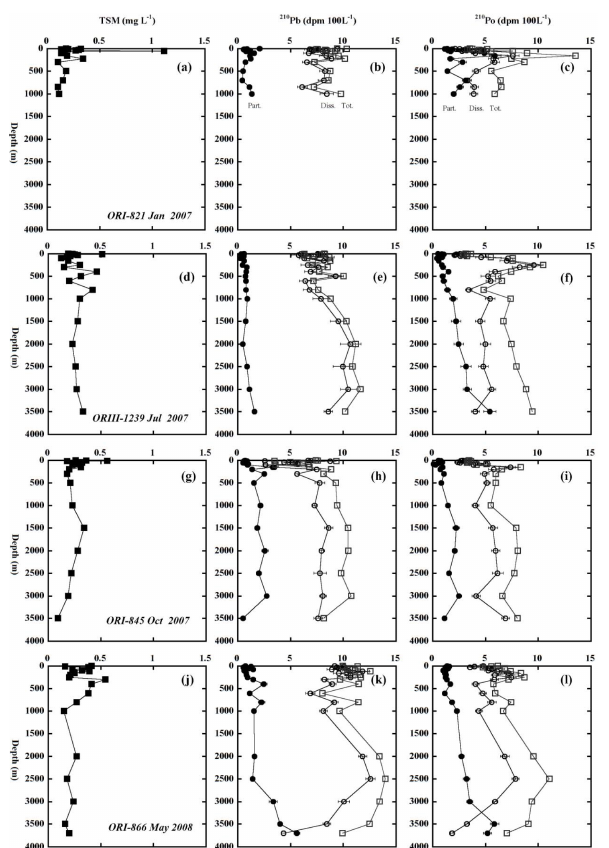
Figure 2. Vertical profiles of TSM concentration, 210 Pb t , 210 Pb d , 210 Pb 210 Po 210 Po 210 Po p , t , p measured from (a)–(c) ORI- d , and 821, (d)–(f) ORIII-1239, (g)–(i) ORI-845, and (j)–(l) ORI-866. Er- ror bars represent uncertainty estimated by counting statistics of ra- dionuclide data ( ± 1 σ)